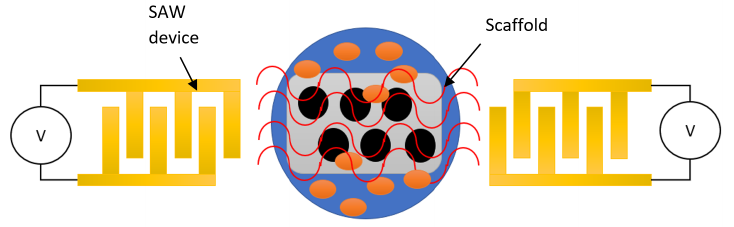
Figure 7. Illustration of cell seeding using SAW device.